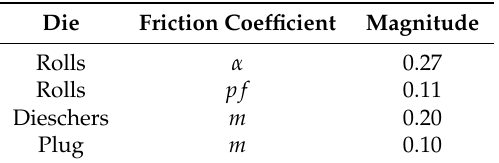
Table 4. Coefficients of the friction models, data from [30].